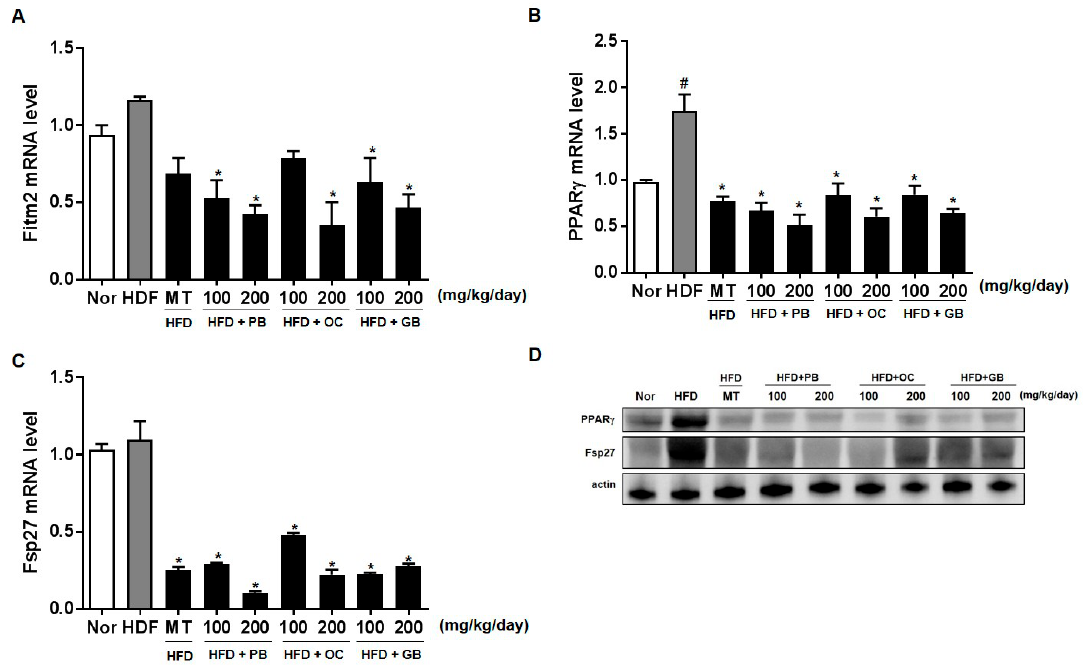
Figure 7. Effects of PB, OC, and GB extracts on the expression of lipogenesis genes in HFD-fed mice livers, determined by RT-PCR. ( A ) Fit2/Fitm2, ( B ) PPAR γ , and ( C ) Fsp27/Cidec expression in the livers. ( D ) Western blot analysis of the corresponding proteins in HFD-fed mice livers. The data are presented as the mean ± SEM ( n = 9); # p < 0.05 compared with the control group; * p < 0.05 compared with the HFD group.